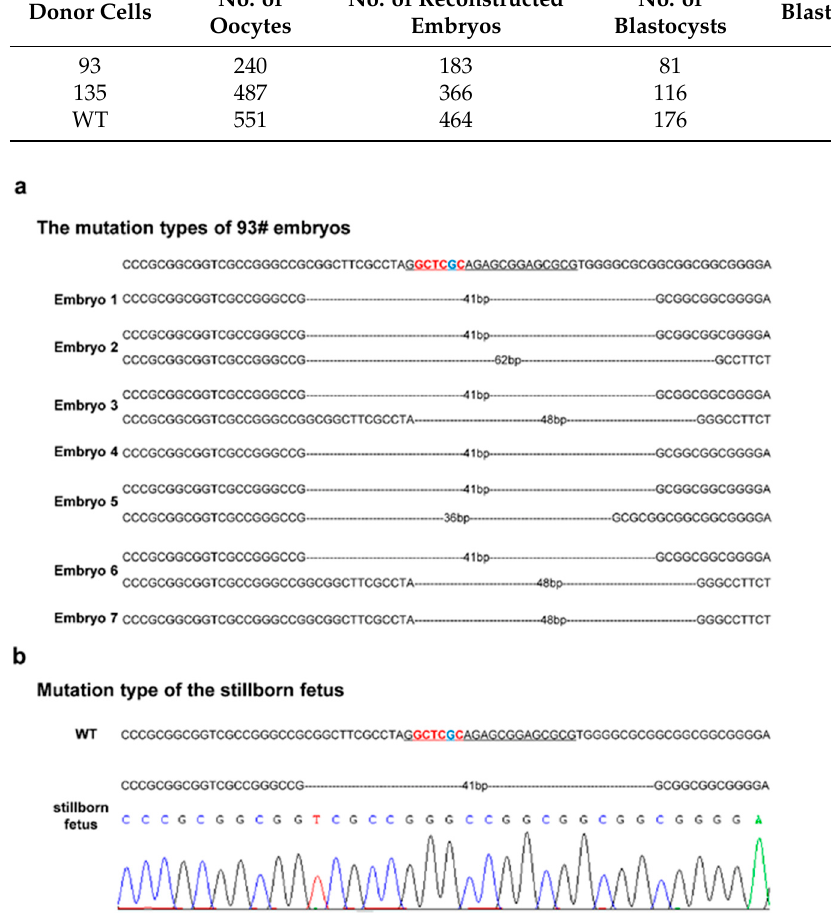
Figure 4. Mutation types in 93 cloned bovine embryos: Identification of mutation types using TA clone sequencing ( a ) in embryos cloned using the single-cell clone 93, and ( b ) in a stillborn fetus. Bases in red represent the ZBED6-binding site, the base in blue represents the key base of the ZBED6-binding site, underlined bases indicate sgRNA, and dashed lines represent base deletion. Table 1. In vitro development of NT embryos derived from single-cell clones 93 and 135. No. of Reconstructed Donor Cells No. of Oocytes Embryos